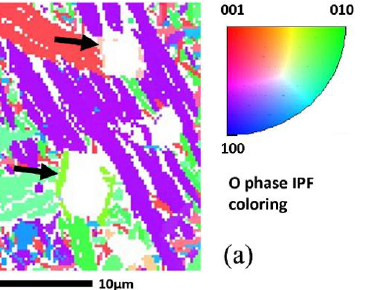
Figure 9. EBSD observation of Ti-22Al-25Nb alloy cooled at 0.1 ◦ C/s from 1020 ◦ C ( a ) IPF map of O phase, ( b ) {110} and <111> pole figures of the B2